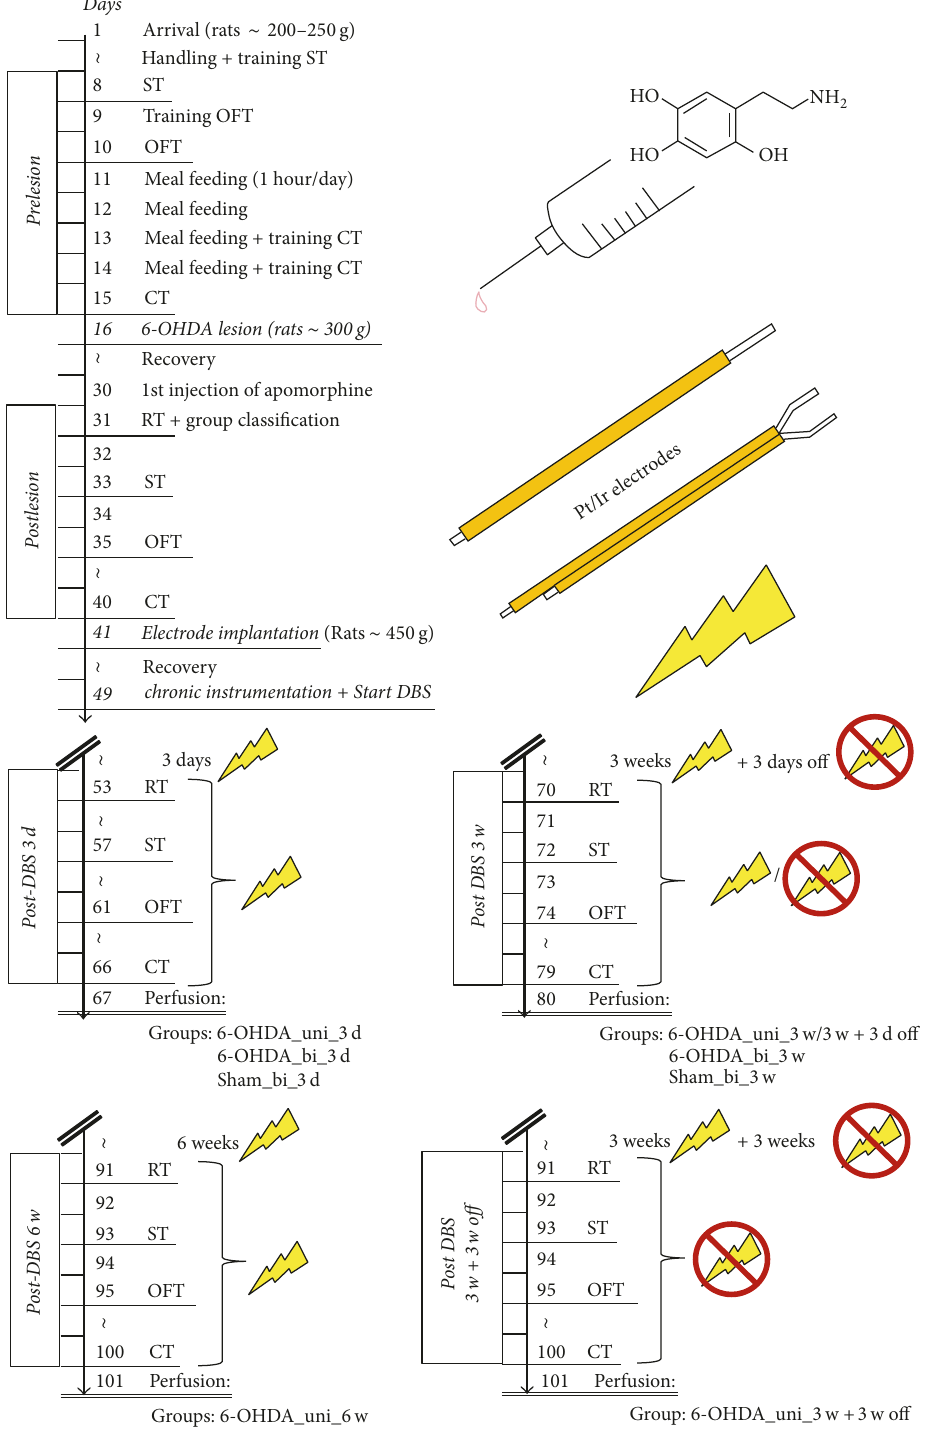
Figure 4: Schedules of the test procedures. RT, ST, OFT, and CT refer to the rotation, stepping, open field, and corridor tests,